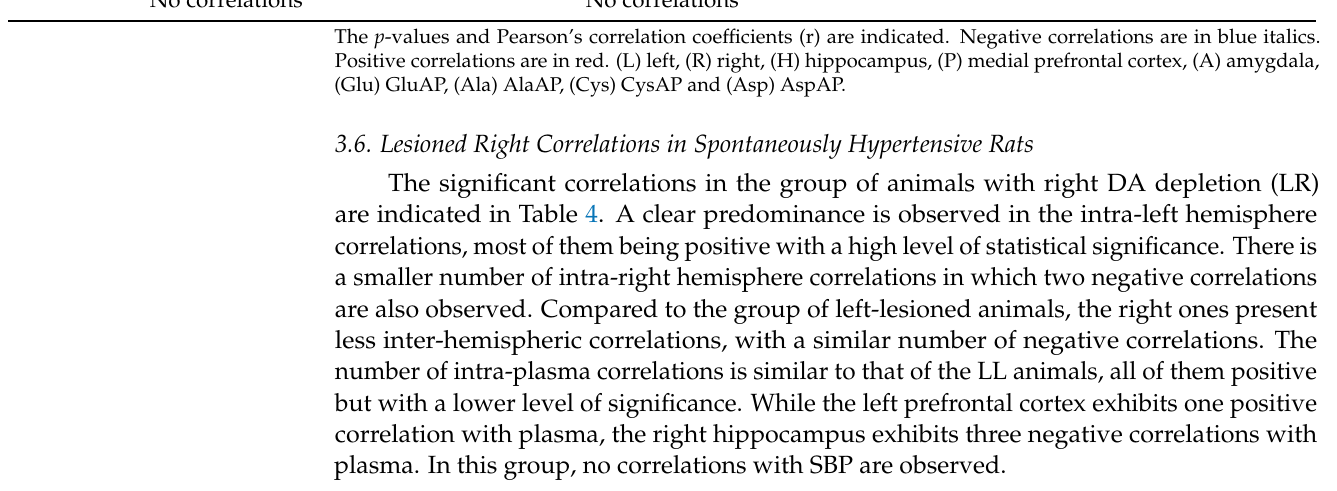
Right Side vs. SBP